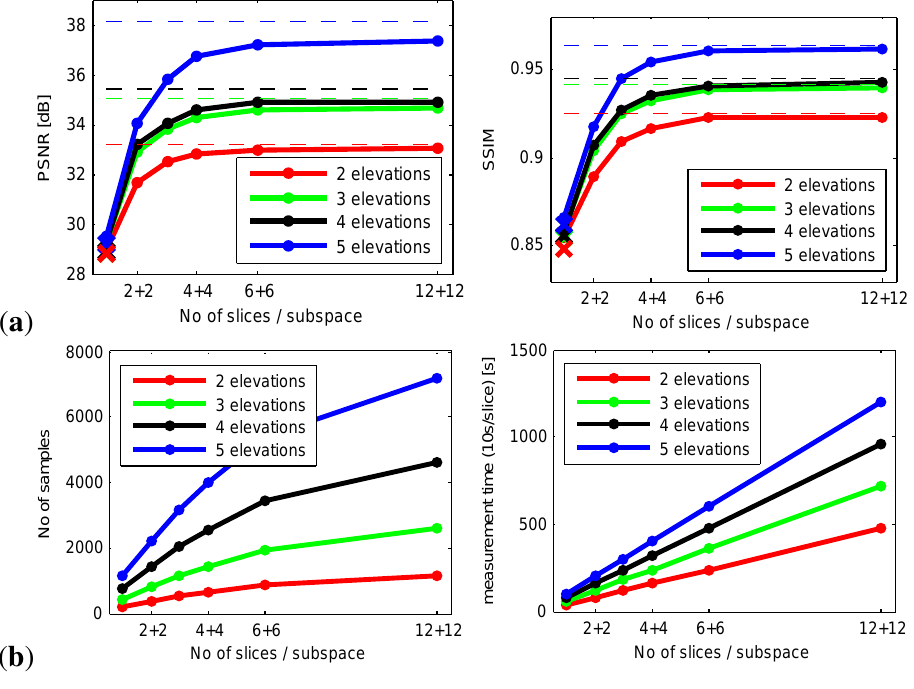
Figure 11. ( a ) Reconstruction error of entire BRDF (left: PSNR, right: SSIM); ( b ) a total number of samples (left) and measurement time (right) as a functions of a number of sampled elevations and slices per